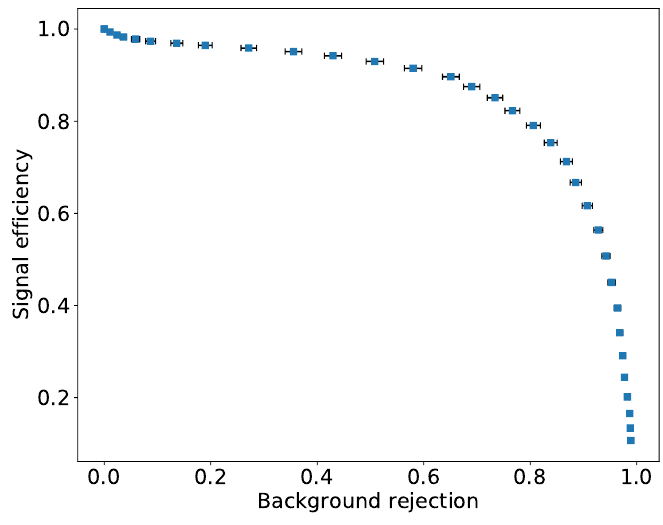
Figure 10 . Signal e(cid:14)ciency as a function of background rejection, varying the required minimum energy of the blob candidate 2 between 0 and 500 keV, in the (cid:12)(cid:12) 0 (cid:23)